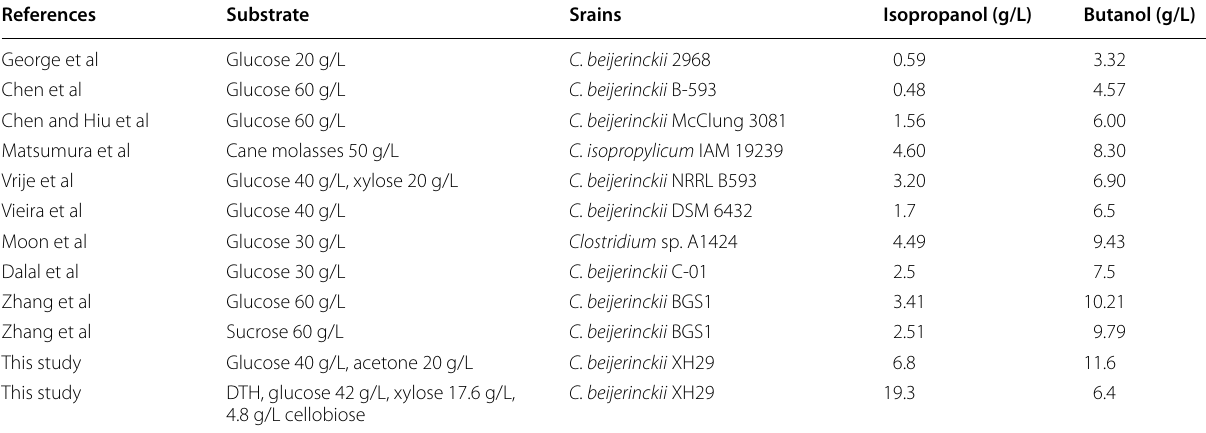
Table 1 Comparison of various BI-producing